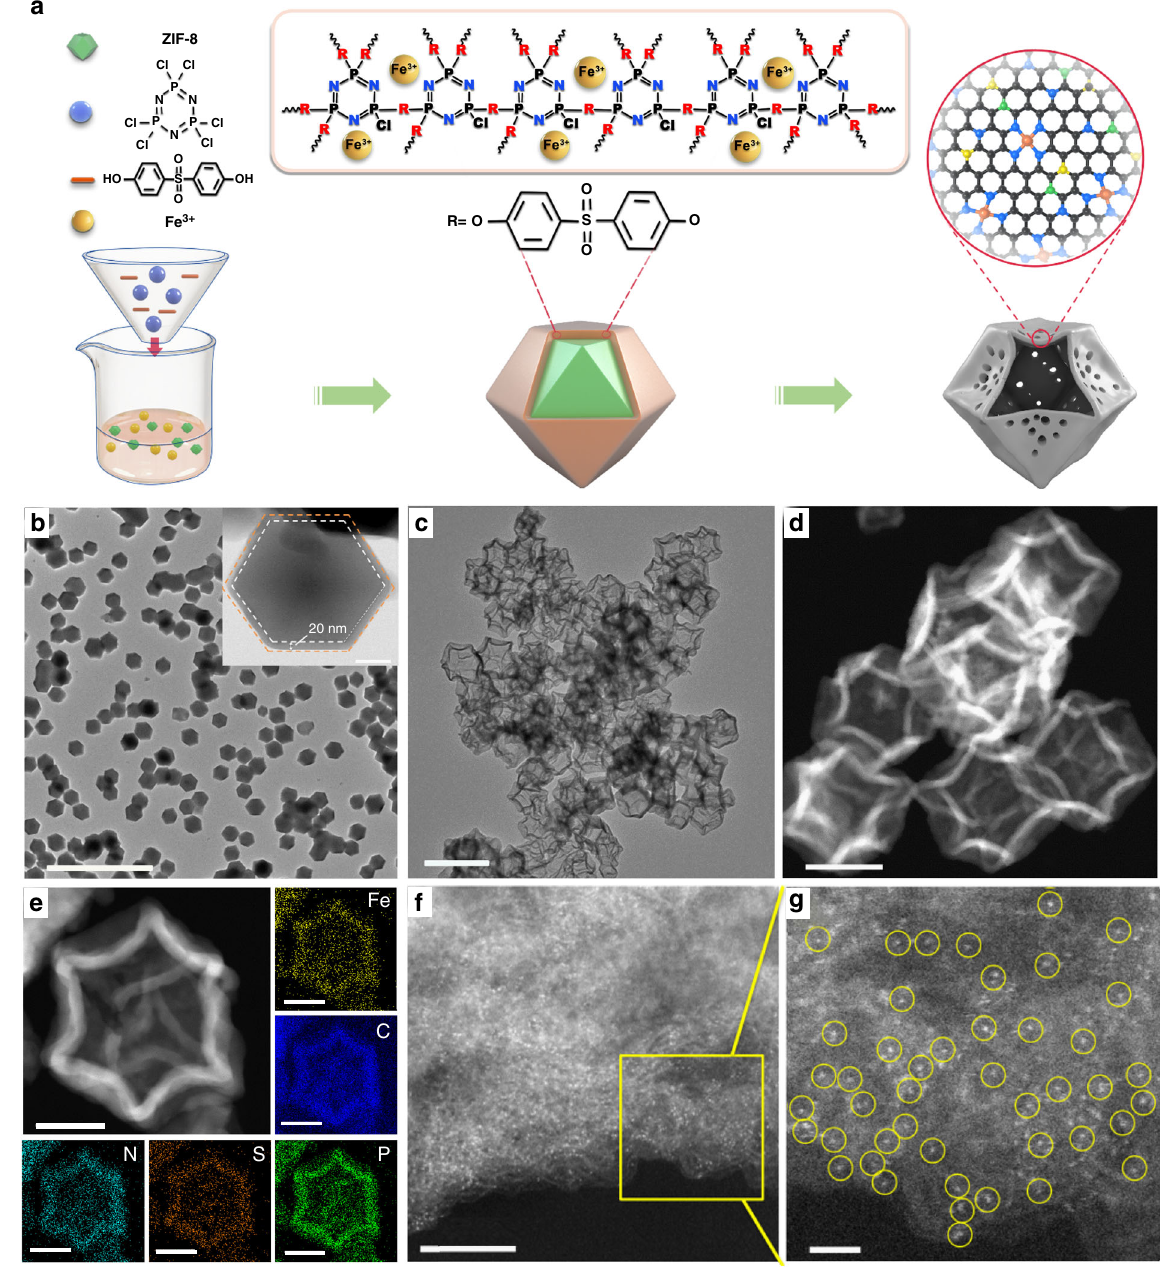
Fig. 1 Synthesis and structural characterizations. a Illustration of preparation process of single iron atomic sites supported on a nitrogen, phosphorus and sulfur co-doped hollow carbon polyhedron (Fe-SAs/NPS-HC). b Transmission electron microscopy (TEM) image of Fe-SAs/NPS-HC predecessor, marked as zeolitic imidazolate framework-8 (ZIF-8)/Fe@poly(cyclotriphospazene-co-4,4 ′ -sulfonyldiphenol) (PZS). Scale bar, 2 μ m. Inset: high-resolution TEM (HRTEM) image of ZIF-8/Fe@PZS, indicating that the thickness of the PZS shell is approximately 20 nm; scale bar, 100 nm. c TEM image of Fe-SAs/NPS- HC. Scale bar, 500 nm. d High angle annular dark fi eld scanning TEM (HAADF-STEM) image of Fe-SAs/NPS-HC. Scale bar, 200 nm. e The enlarged HAADF-STEM image and corresponding element maps (Fe: yellow, C: blue, N: cyan, S: orange, P: green). Scale bar, 100 nm. f , g Aberration-corrected (AC) HAADF-STEM image and enlarged image of Fe-SAs/NPS-HC catalyst. Scale bar, 5 nm ( f ); 1 nm ( g